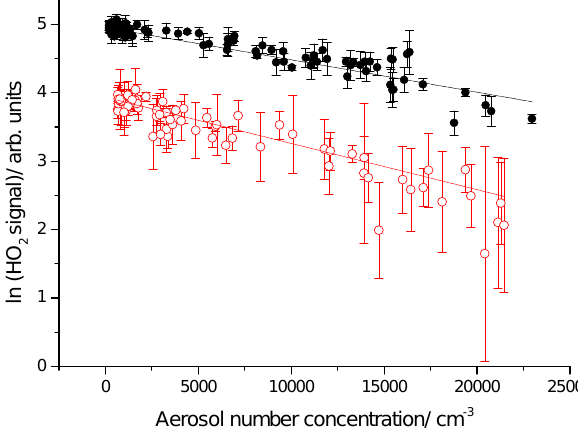
Figure 4. The exponential dependence of the measured HO 2 signal with the ATD aerosol number concentration. The data are for an initial HO 2 concentration of 1 × 10 9 molecule cm -3 , at a relative humidity of 76% RH and at injector positions of 30 cm (black points) and 80 cm (red points). The solid lines show the linear least-squares fit to the data, whose slopes are equal to -0.25 γ obs wA d t (see Equation 3 in text). The HO 2 signal was averaged for 3 seconds at each point and the error bars represent 1 standard deviation.